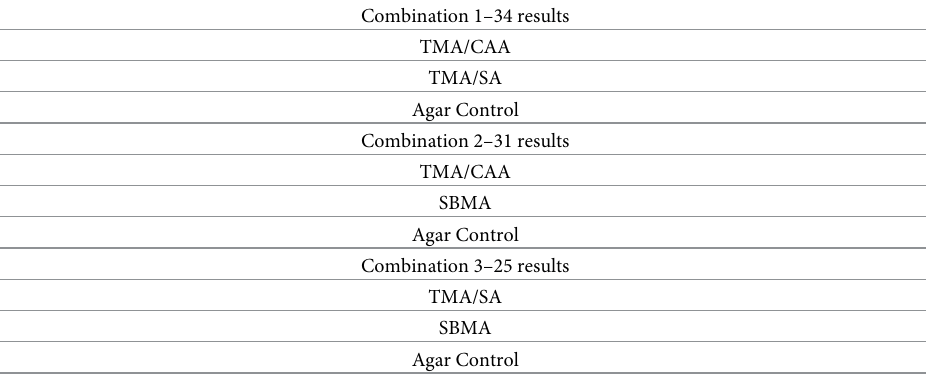
Table 1. Summary of the data collected from citizen science kits.